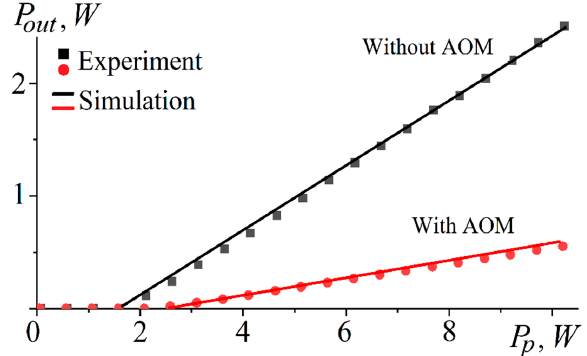
Figure 5. Dependence of the output radiation power on the pump power. 1—cavity without AOM, 2—working AOM is placed inside the cavity. Points—experimental data, Lines—simulated data.